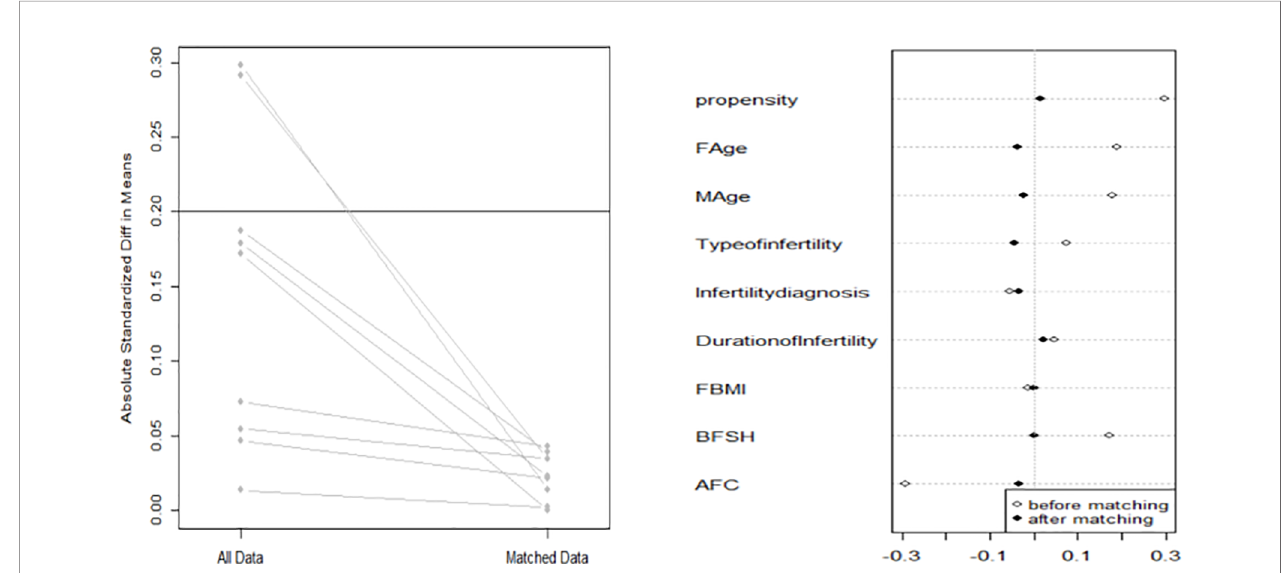
FIGURE 1 | After 1:1 PSM, the data heterogeneity between the two groups was signi fi cantly